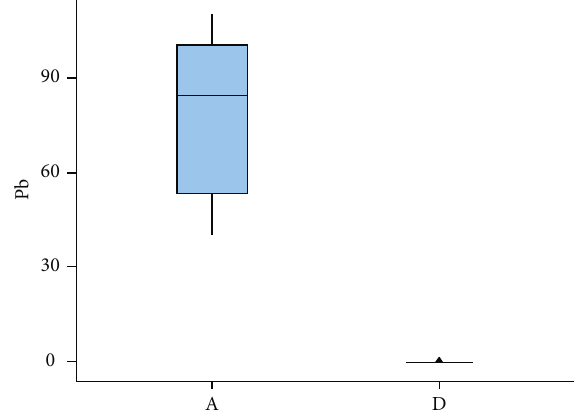
Figure 4: Graphic showing Pb concentration before and after phytoremediation. The [22] Jamovi project (2019) and [41] R Core Team (2018).